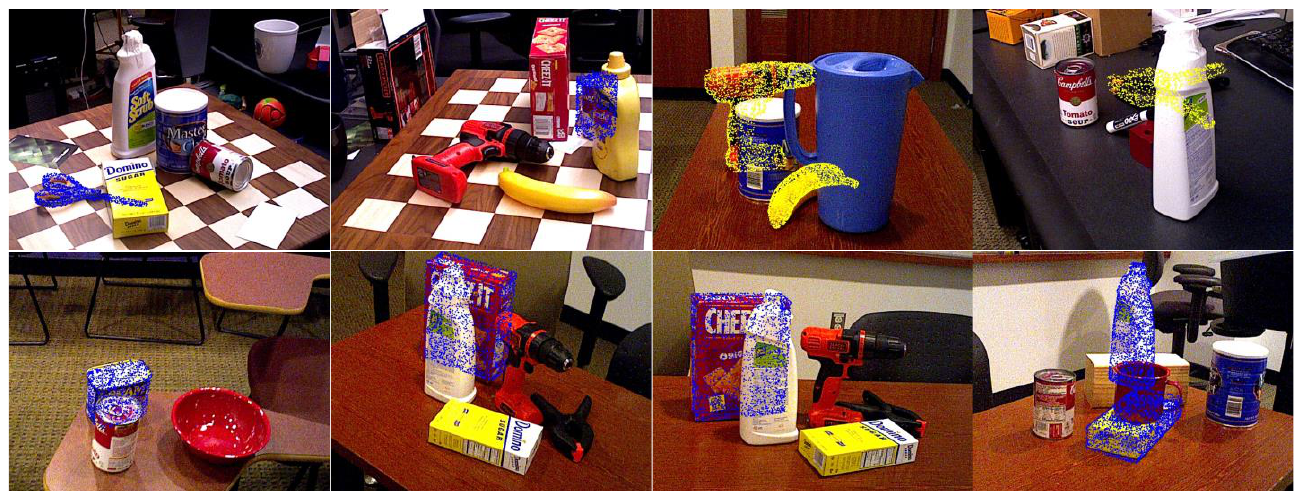
Figure 8. Visualized results of our method on the YCB-Video Dataset when objects are occluded.